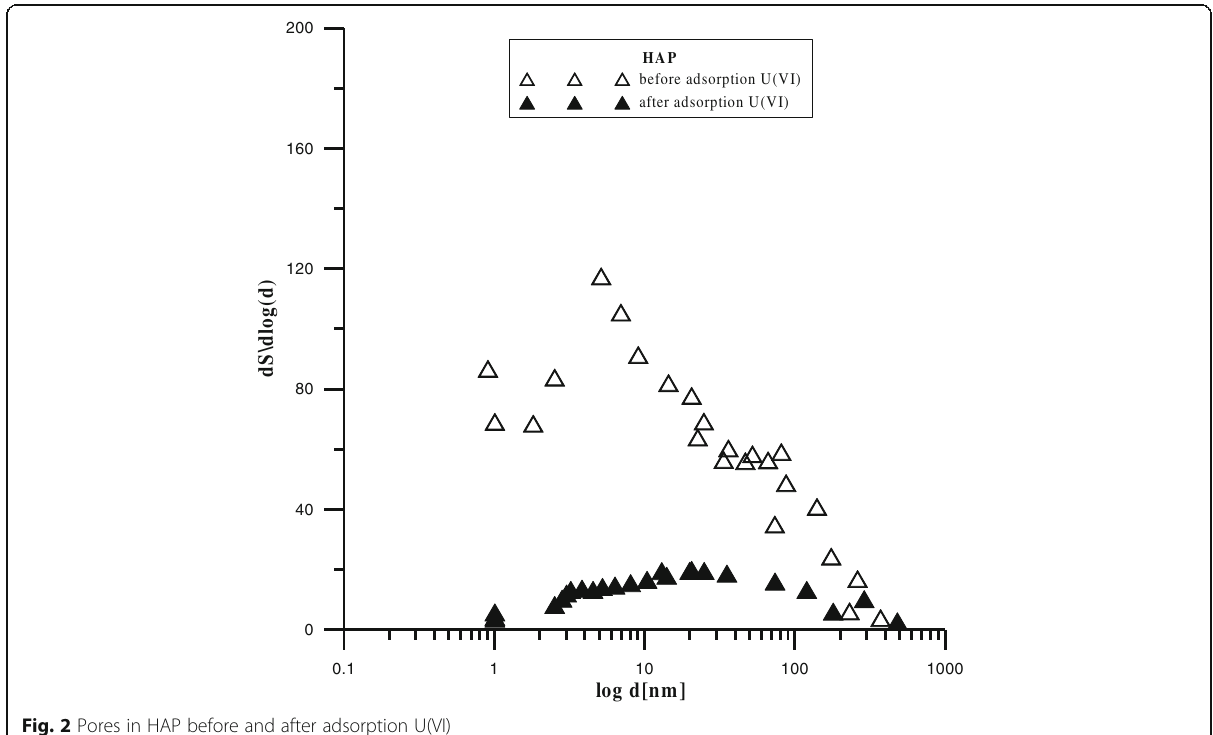
Fig. 2 Pores in HAP before and after adsorption U(VI)